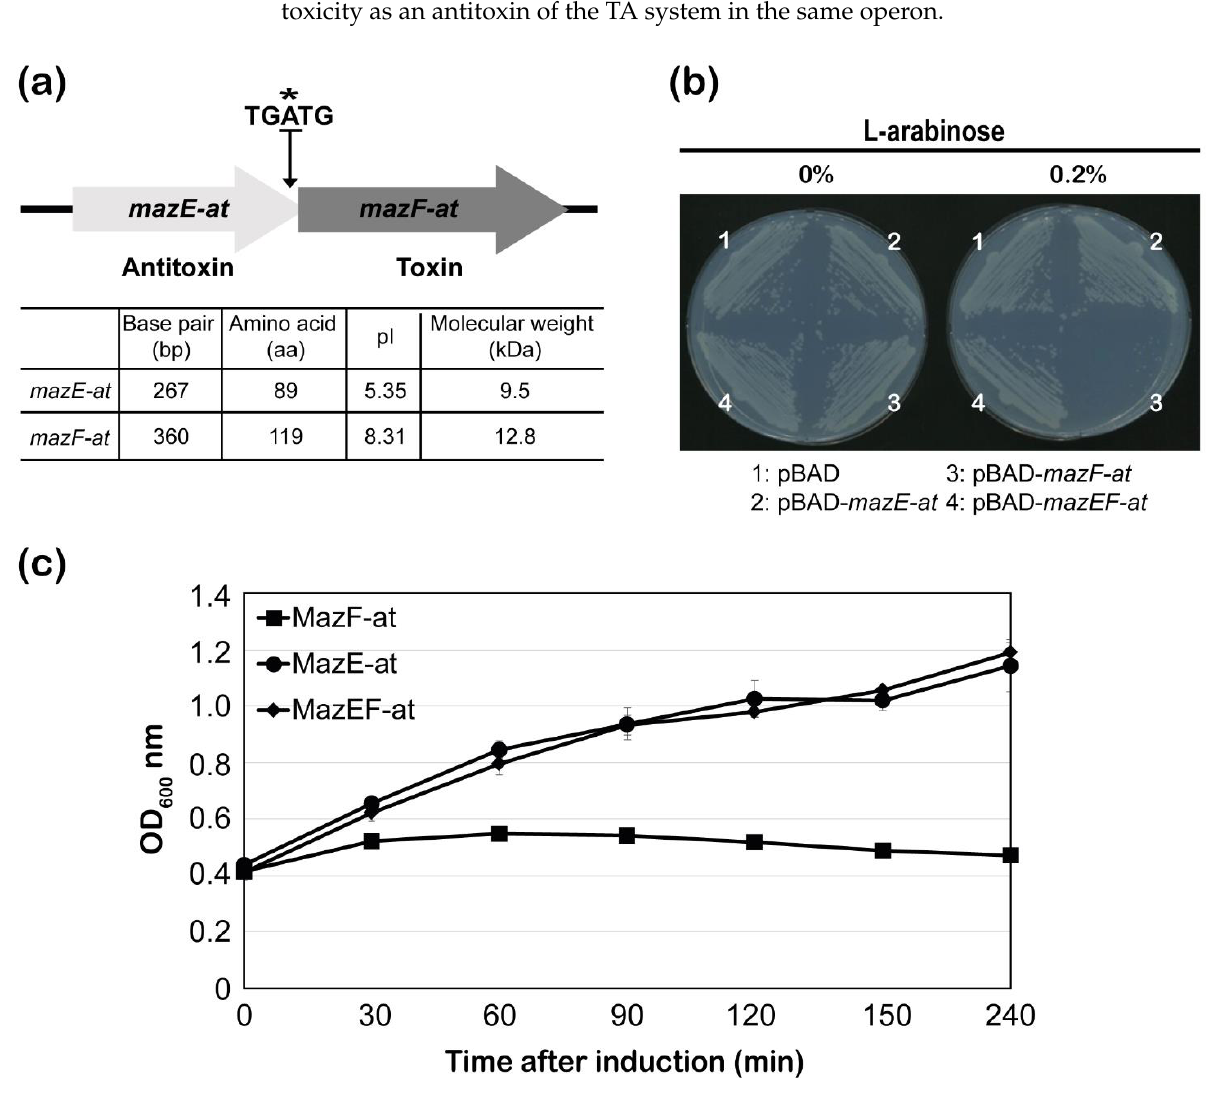
Figure 1. The characterization of the MazEF-at TA system in Agrobacterium tumefaciens. ( a ) Gene map of the mazEF-a. The asterisk indicates the nucleotide where the orf of the two genes overlap. The table includes the gene length, number of amino acids, theoretical pI, and molecular weight of MazE-at and MazF-at; ( b ) Toxicity of MazF-at on plates. The cells of Escherichia coli BW25113 harboring pBAD24- mazE-at (2), - mazF-at toxin (3), - mazEF-at (4) or pBAD24 only (1) were incubated on the M9 plate with or without 0.2% L-arabinose; ( c ) Effect of MazF-at on cell growth induction. The culture of E. coli BW25113 harboring pBAD24- mazE-at (black circle), - mazF-at (black square), or – mazEF-at (black rhombus) was grown until the OD 600 nm (optical density) of the culture reached ~0.4, followed by adding 0.2% L-arabinose at 0 min, and bacterial growth was measured for 6 h at OD 600 nm. Error bars represent the standard error of the mean (SEM).